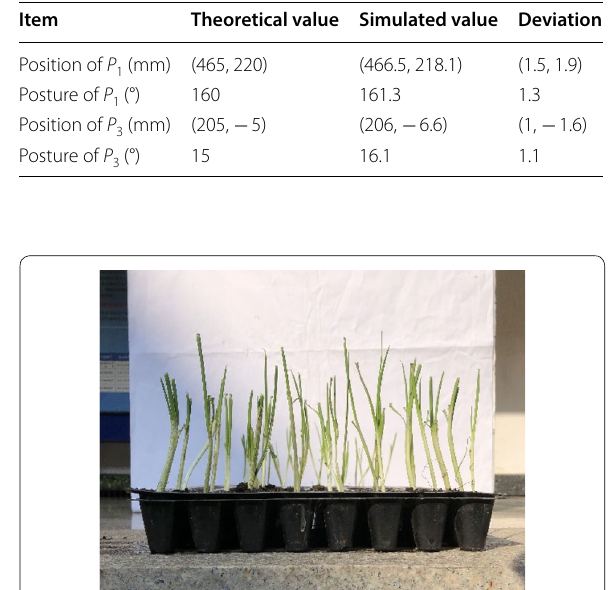
Table 4 Comparison between theoretical and simulated trajectories at key operating